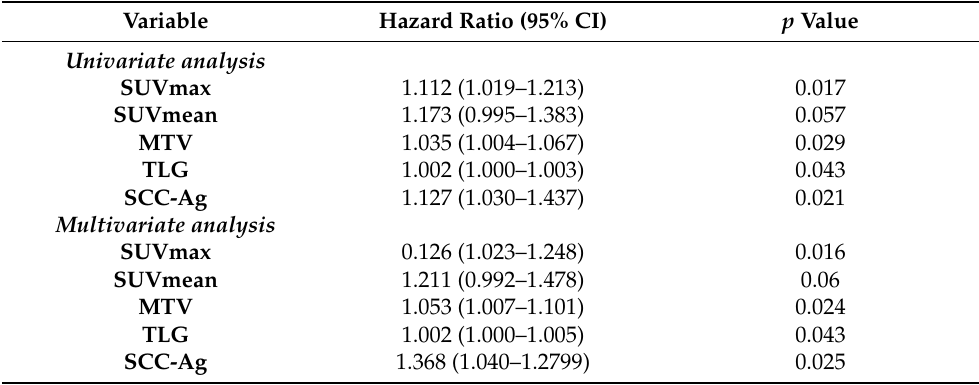
Table 5. Univariate and multivariate Cox regression analysis for overall survival.